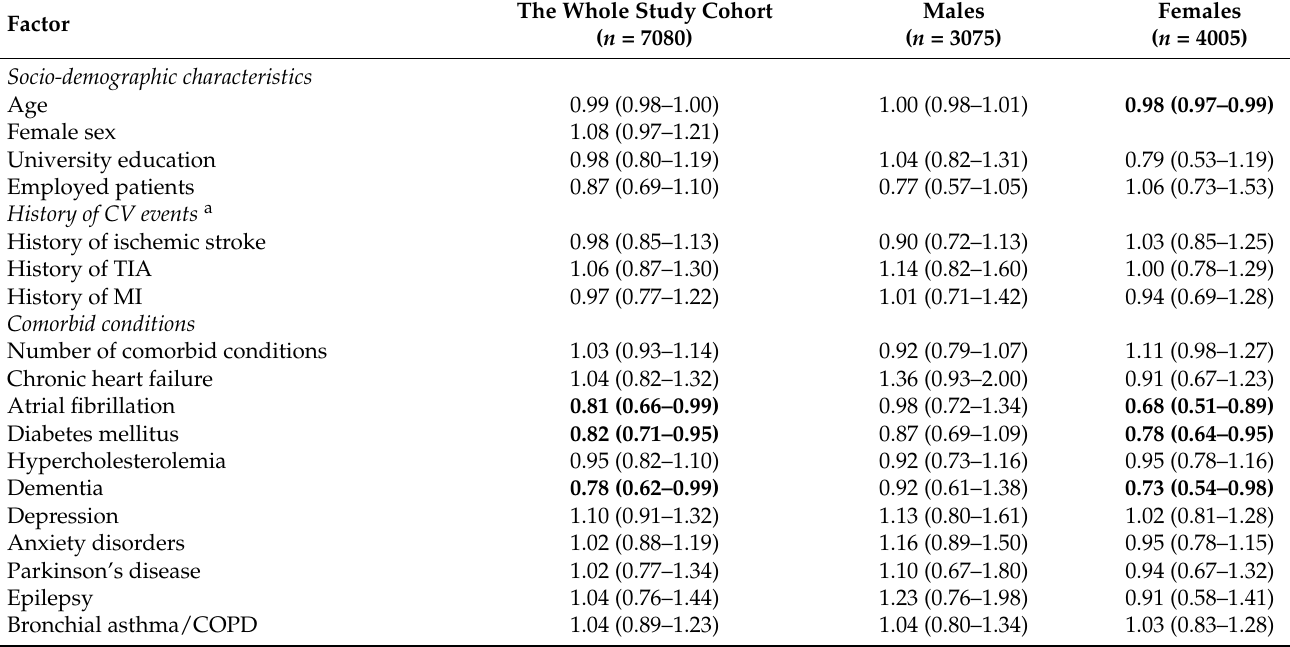
Figure 3. Differences in persistence between users of angiotensin-converting enzyme inhibitors (ACEIs) and angiotensin receptor blockers (ARBs) ( a ) in the whole study cohort; ( b ) among males; and ( c ) among females. Table 2. Multivariate analysis of the association between patient- and medication-related character- istics, and the probability of non-persistence in the whole study cohort and in the groups of males and